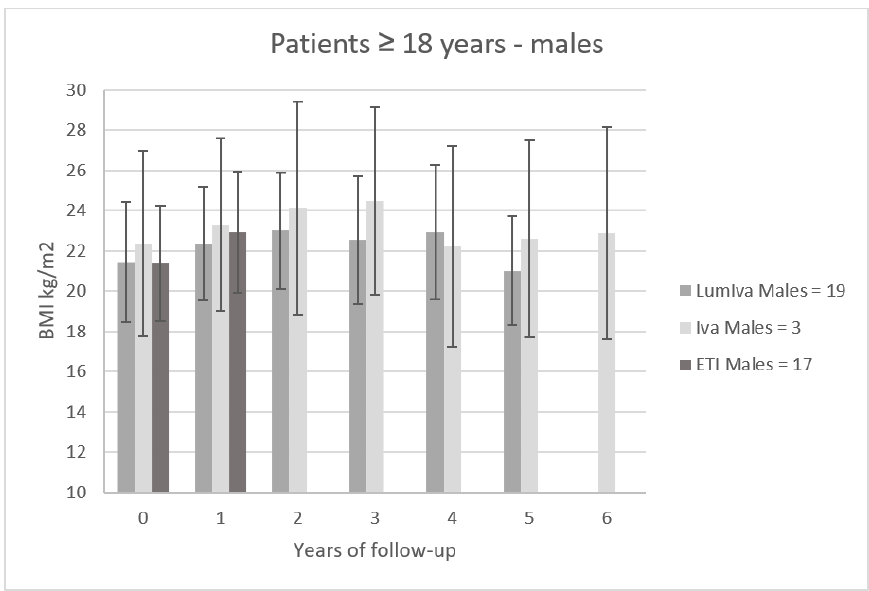
Figure 2. BMI trend (mean ± SD) in 39 male patients aged ≥ 18 years treated with modulators (Iva N = 3, LumIva N = 19, and ETI N = 17).